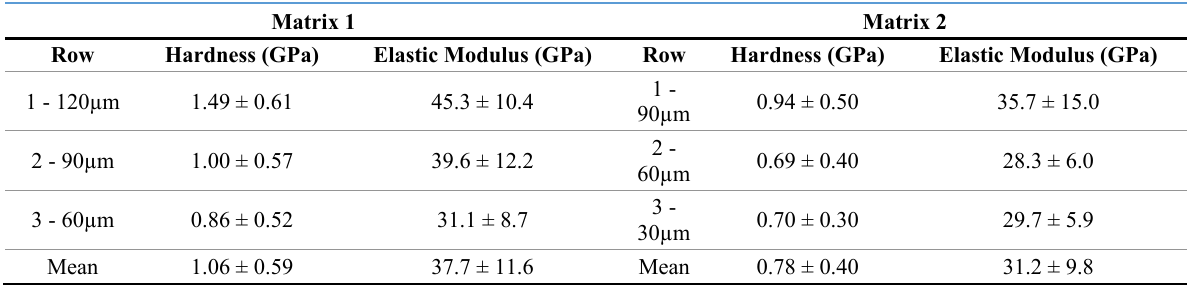
Table 2. Average results obtained at the steel microfiber-cementitious matrix interface.